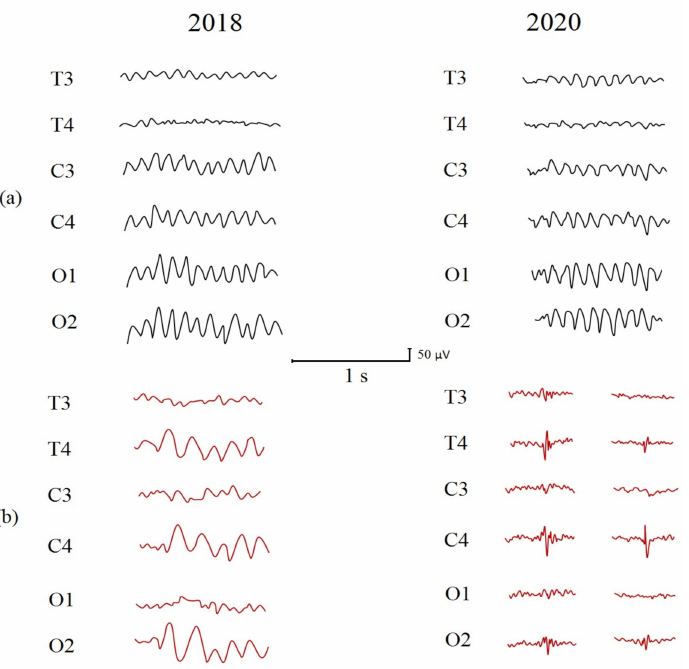
Figure 2. ( a ) Dominate alpha rhythm with eyes closed, ( b ) the abnormalities of the background EEG. Table 1. Amplitudes of 40-Hz auditory steady-state response (ASSR) and event-related potential (ERP) components (mean ± STD) for two comparison groups of typically developing children and SH01 in Fz electrode. ASSR, µ V P1, µ V N1, µ V P2, µ